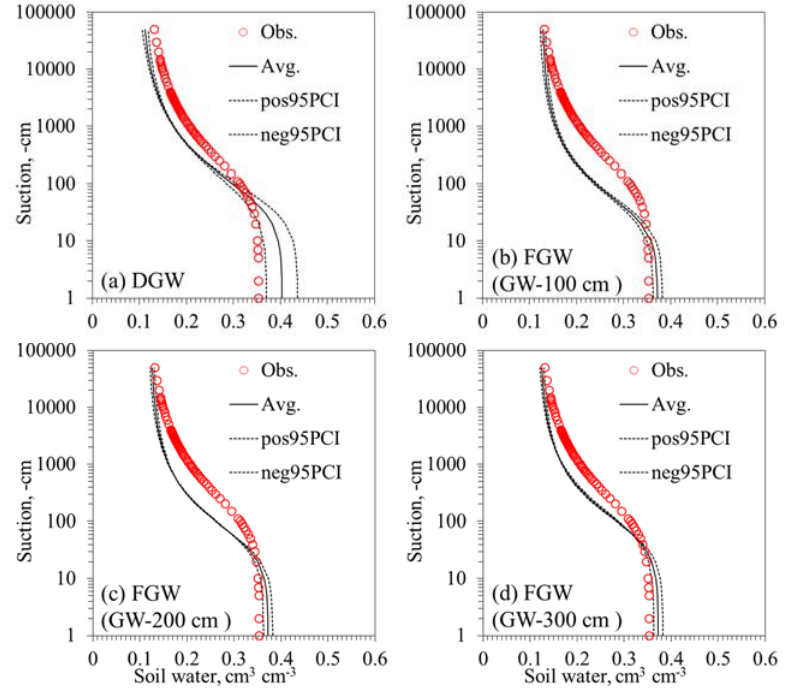
Figure 10. Observed and estimated water retention curves ( θ ( h )) using DGW ( a ) and FGW ( b – d ) data assimilation schemes at LW 13 site (1997).